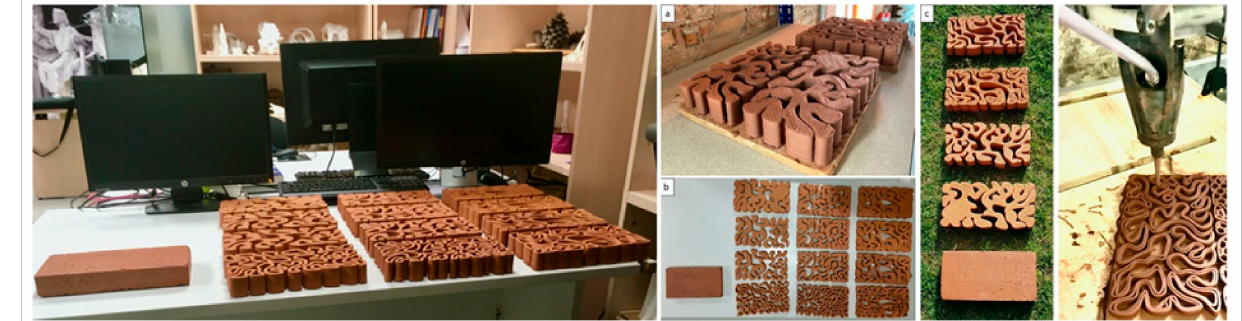
Figure 10. Alberto T. Est é vez (Yomna K. Abdallah, computational designer), Biodigital Barcelona Bricks (3D-printed clay), GENARQ/iBAG, UIC Barcelona. ( a – c ) show different iterations (V1, V2, and V3) printed with clay. Right: 3D printing process of the linear model. Photos by the